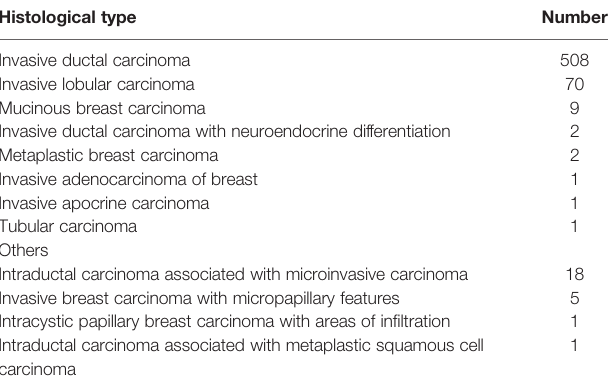
TABLE 1 | Pathologic diagnosis in 619